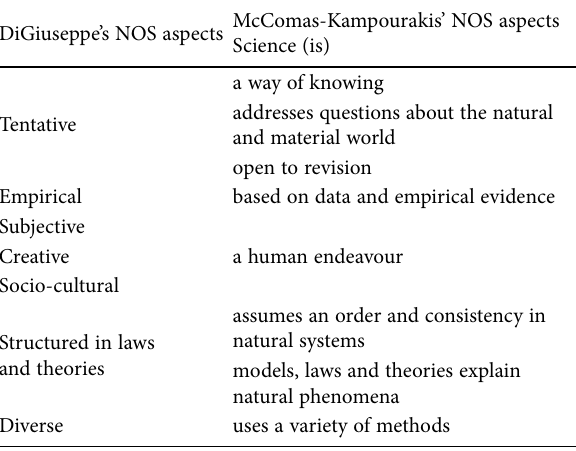
Table 1. A comparative connection between DiGiuseppe’s (2014) 10 and McComas-Kampourakis’s (2015) 9 NOS